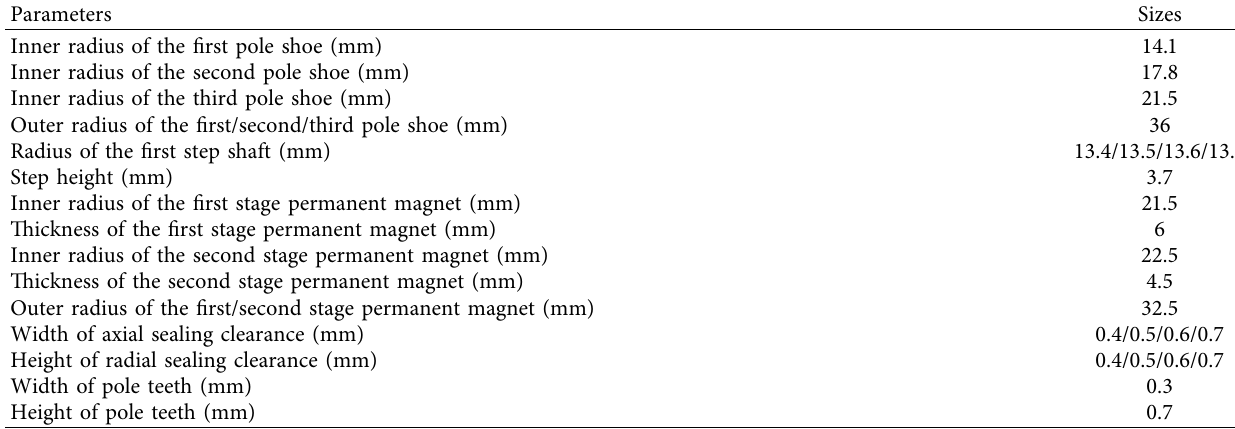
Table 1: Structural parameters of divergent magnetic fluid seal with large clearance.